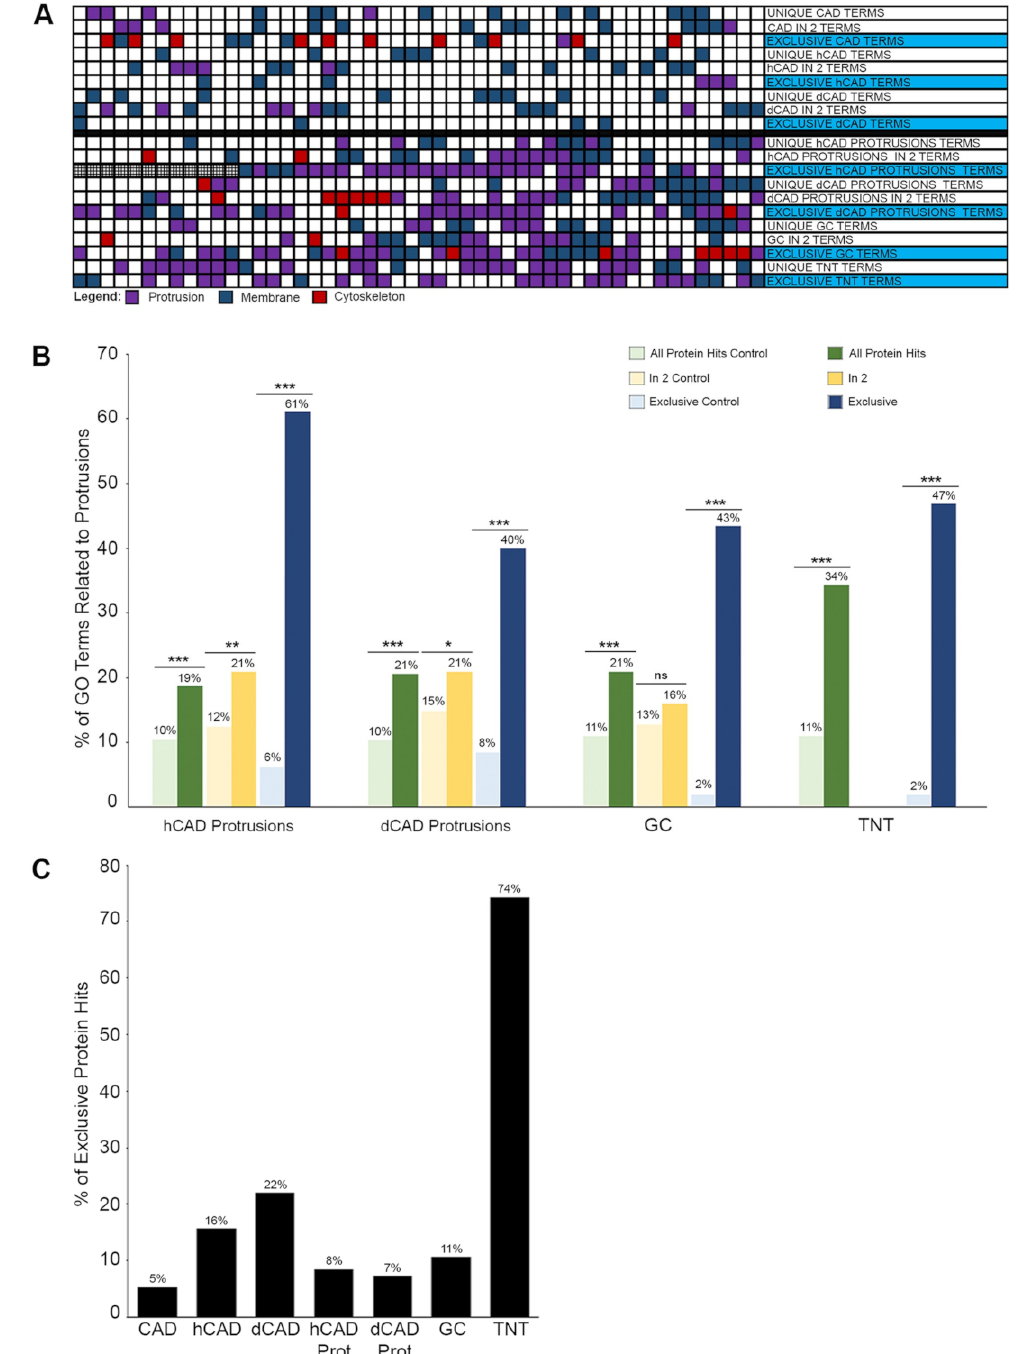
Figure 6. Graph analysis of cellular protrusions using annotations. ( A ) A global colorimetric view of the top 50 GO Terms for each sample highlights the increase in GO Terms related to protrusions (i.e., violet) in protrusion samples (bottom) compared to whole cells (top), confirming the HPA data analysis (Figure 5I). ( B ) Comparison of the % of GO Terms related to protrusions based on additive (proteins in 2 samples) or subtractive (exclusive to one type of protrusion) analyses, with a p value < 0.001 (***), < 0.01 (**), or < 0.05 (*). Additive analysis (yellow) on small LCM/MS protrusion samples is not optimal compared to the subtractive approach (blue), which resulted in 40–60% GO Terms enrichment. By subtracting the most abundant proteins found, thereby creating a list of “exclusive proteins”, less abundant, most significant proteins were identified in all subtype of protrusions. ( C ) Graphical representation of the % of exclusive protein hits per type of protrusions show a distinct proteome for each protrusion